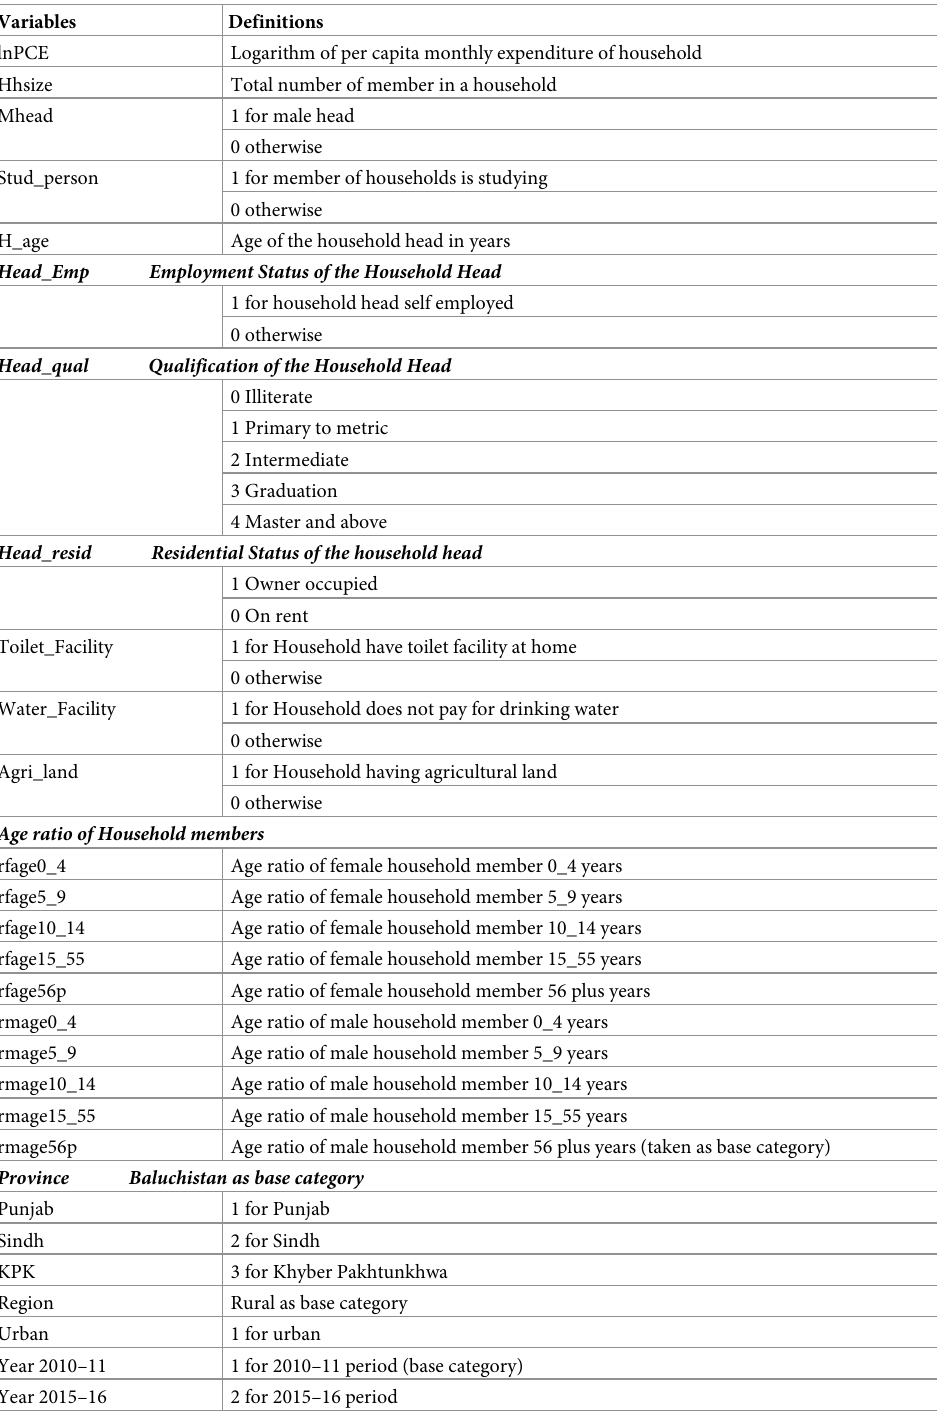
Table 2. Description of